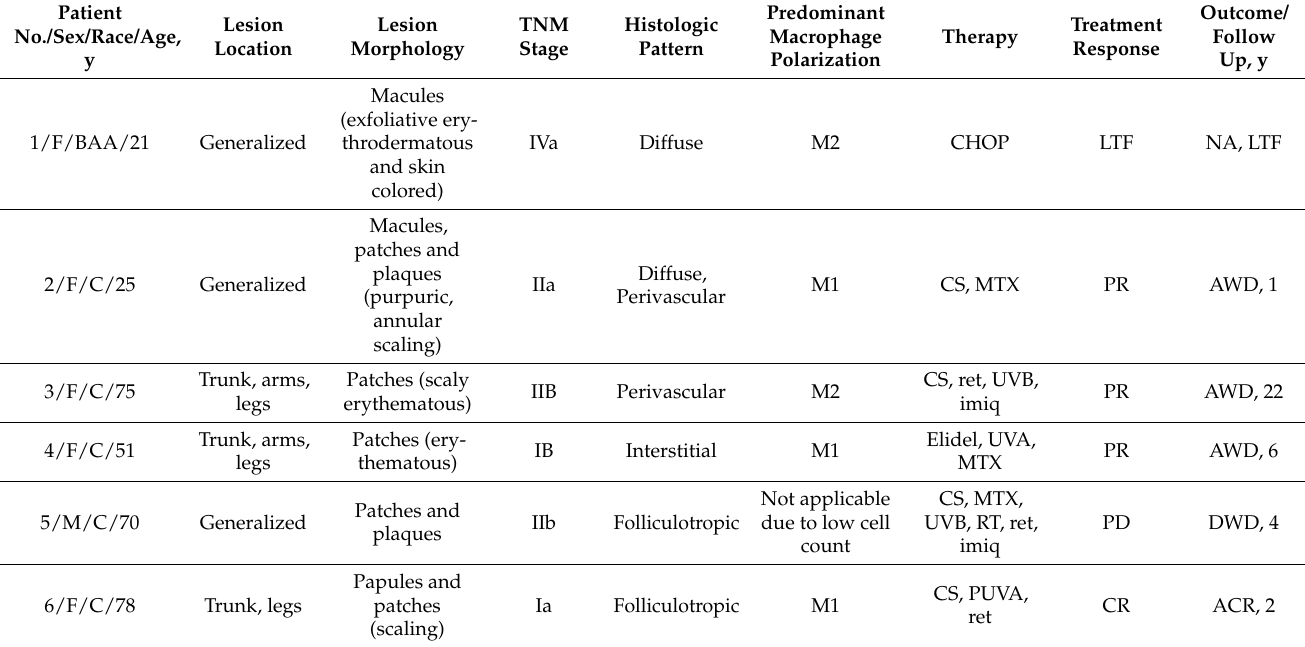
Table 1. Clinical, histologic, immunophenotypic, and treatment data of 6 patients with granulomatous mycosis